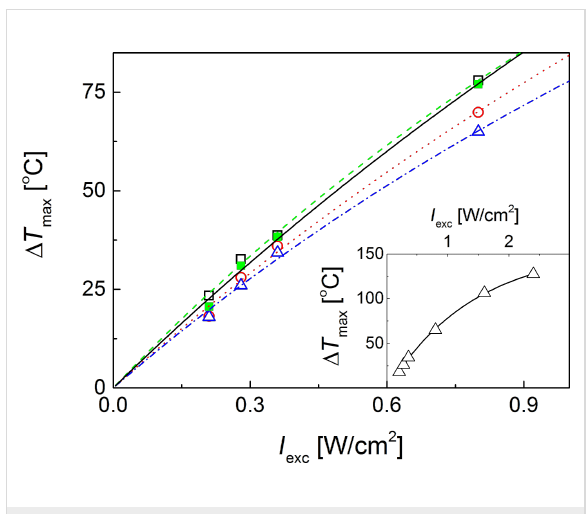
Figure 2: Dependence of temperature increase of GNS patterns printed on the non-permeable (filled squares), the semi-permeable (open squares and circles) and permeable (triangles) paper sub- strates as a function of the NIR laser intensity. The drop density of the ink for the samples was 31212 drops/mm 2 (filled squares); 71407 drops/mm 2 (open circles); 121203 drops/mm 2 (open squares) and 202005 drops/mm 2 (open traingles). Inset: dependence of temper- ature increase of GNS patterns printed on the permeable substrate (laser intensity above 0.8 W/cm 2 ). The trial fitting function and the cor- responding best fit parameters are provided in Supporting Information File 2. Figure 3: Photothermal effect as a function of the amount of printed